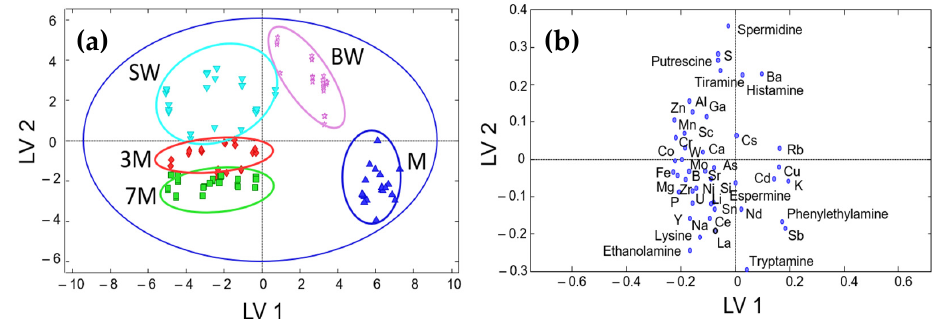
Figure 3. Plots of scores ( a ) and loadings ( b ) from low-level data fusion. ( a ) Scatter plot of LV1 vs. LV2 scores; ( b ) scatter plot of LV1 vs. LV2 loadings. Sample assignment: M = must (blue); BW = base wine (light purple); SW = stabilized wine (light blue); 3M = sparkling wine with 3 months of aging (red); 7M = sparkling wine with 7 months of aging (green).